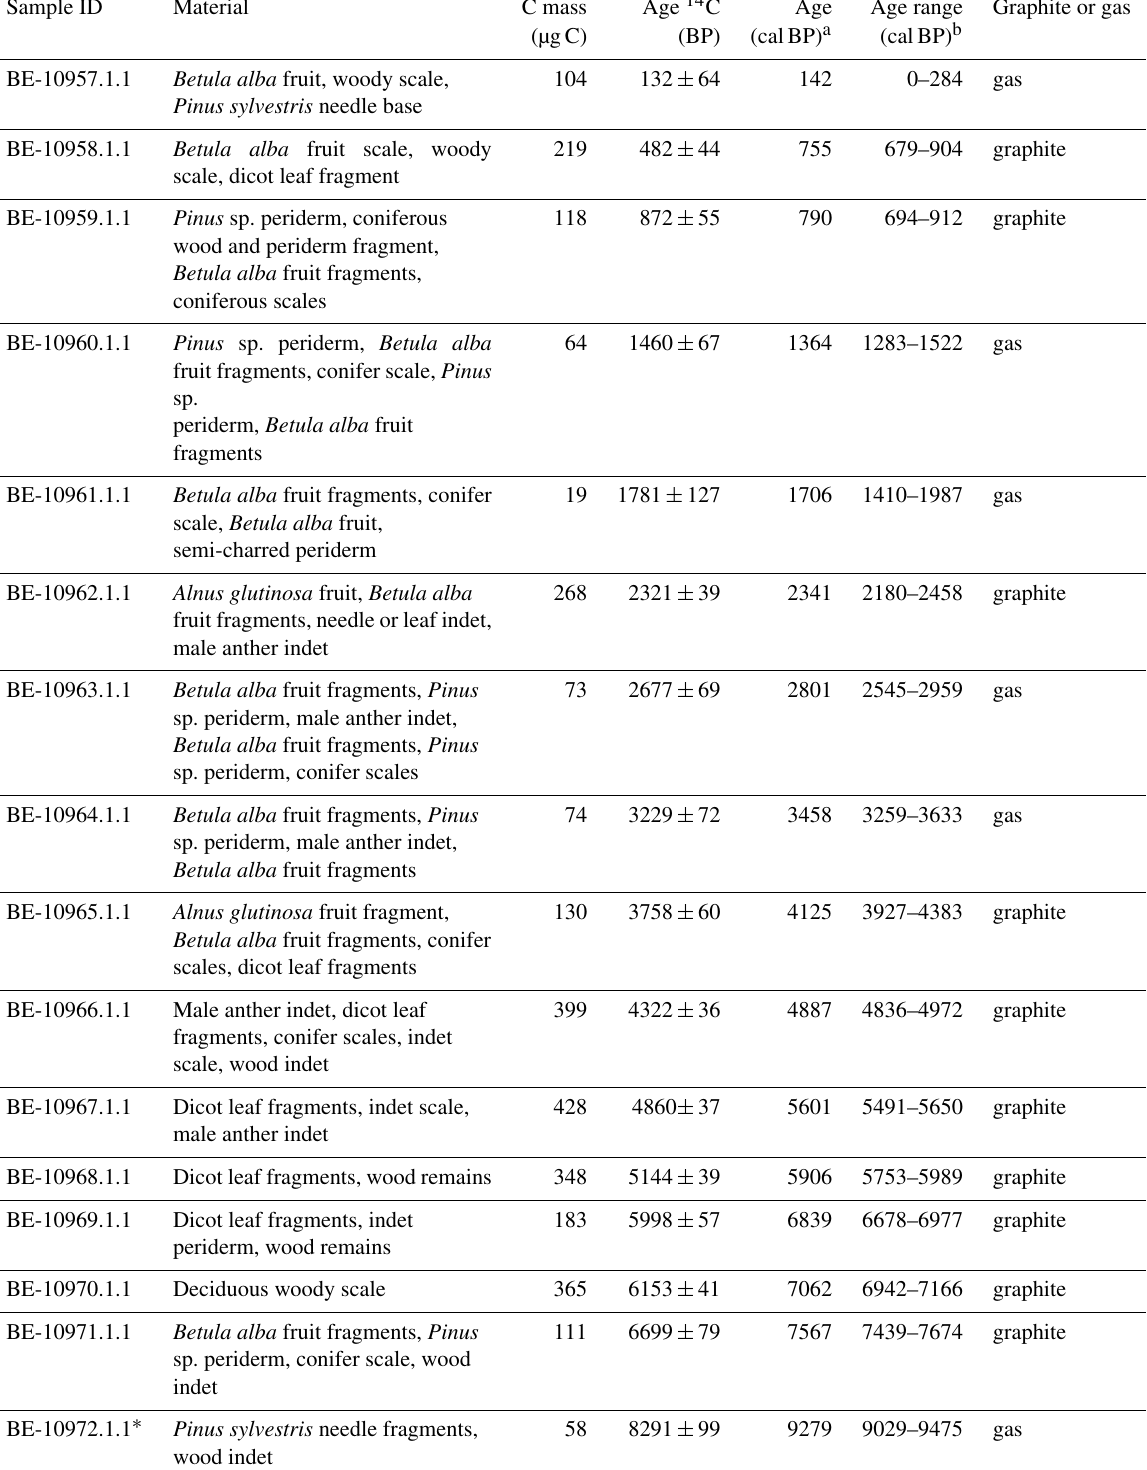
Table 1. Radiocarbon age results and calibrated ages. Uncertainties for 14 C ages refer to 68% probabilities (1 σ ), whereas ranges of calibrated ages refer to 95% probabilities (2 σ ). Outlier samples are marked with an asterisk. The abbreviation indet denotes indeterminable; dicot denotes